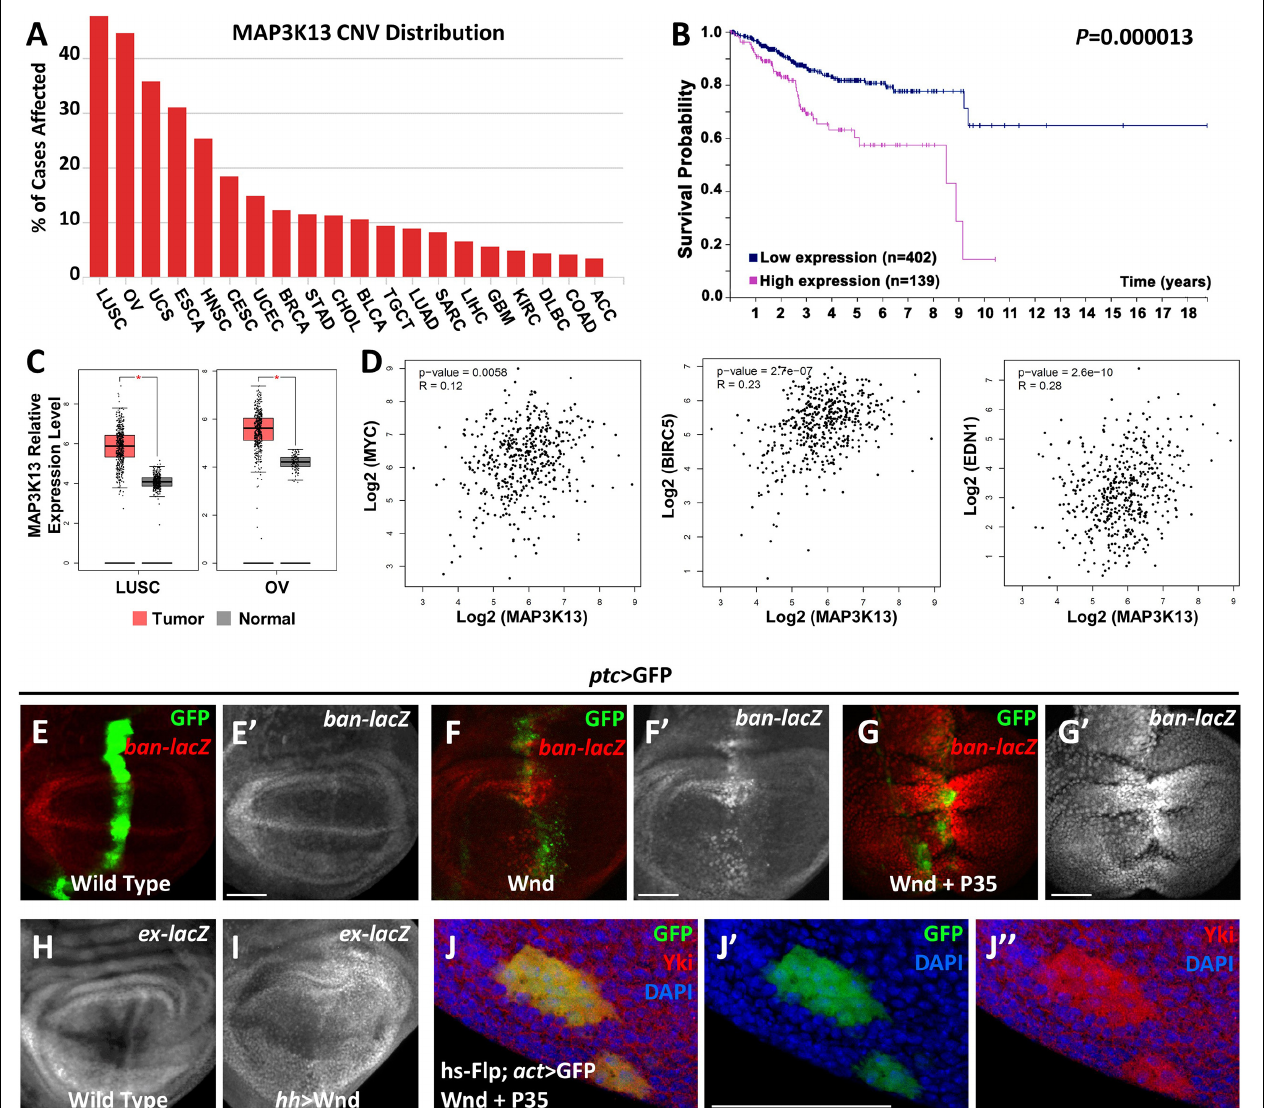
FIGURE 1 | MAP3K13/Wnd activates expression of Hippo pathway target genes. (A) The distribution of copy number variation (CNV) of MAP3K13 across different cancer types. (B) Analysis of the prognostic significance of high and low expression level of MAP3K13 in endometrial cancer. (C) Box plots showing the relative expression level of MAP3K13 in lung squamous cell carcinoma (LUSC) and ovarian serous cystadenocarcinoma (OV). (D) Expression correlation between MAP3K13 and MYC , BIRC5 , or EDN1 , three target genes downstream of the transcriptional co-activators YAP/TAZ, in LUSC. (E–J (cid:48)(cid:48) ) Wing imaginal discs from third instar larva are shown. Compared with wild type controls (E,E (cid:48) ) , expression of Wnd for 2–3 days (F,F (cid:48) ) or co-expression of wnd and P35 (G,G (cid:48) ) driven by ptc -Gal4 (GFP positive area) elevates ban expression level. Expression of Wnd in the posterior region of wing disc elevates ex expression level (I) , compared with wild type controls (H)